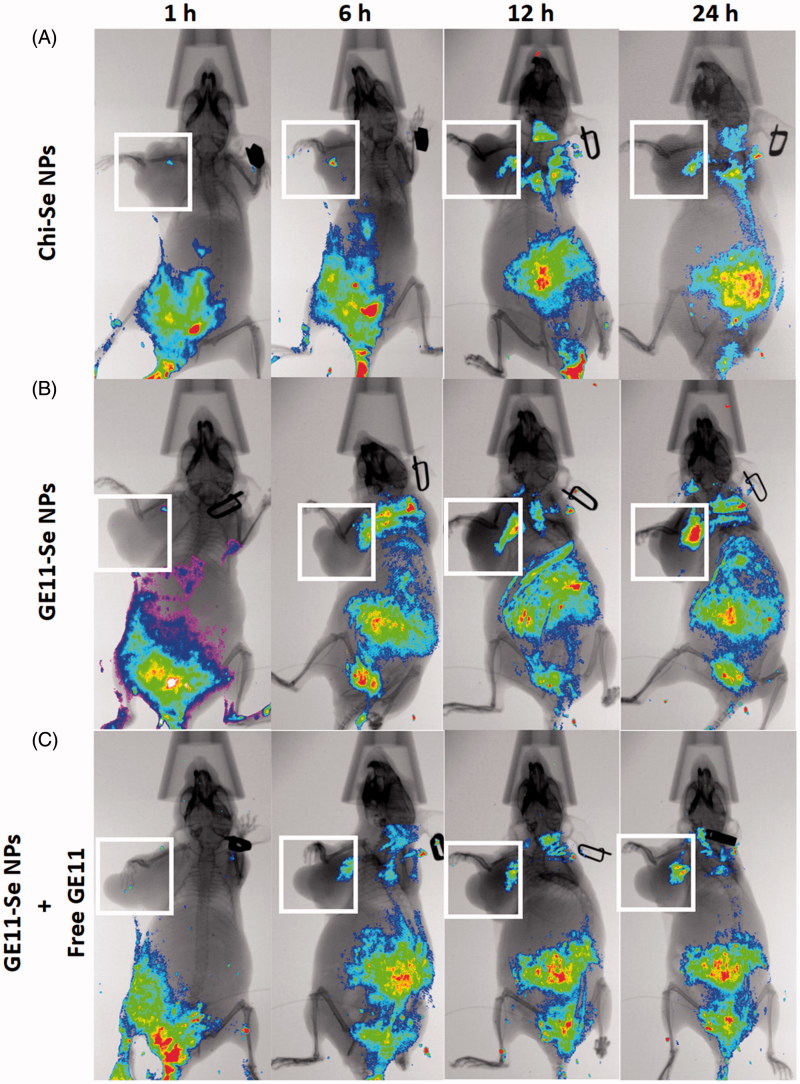
In vivo distribution of GE11-Se NPs in xenograft KYSE-150 cancer nude mice. In vivo fluorescence imaging of the esophageal cancer-bearing nude mouse after tail intravenous injection of (A) coumarin-6-loaded Chi-Se NPs, (B) coumarin-6-loaded GE11-Se NPs, and (C) coumarin-6-loaded GE11-Se NPs in the presence of large amounts of free GE11 peptide. The white squares indicated the location of tumor.